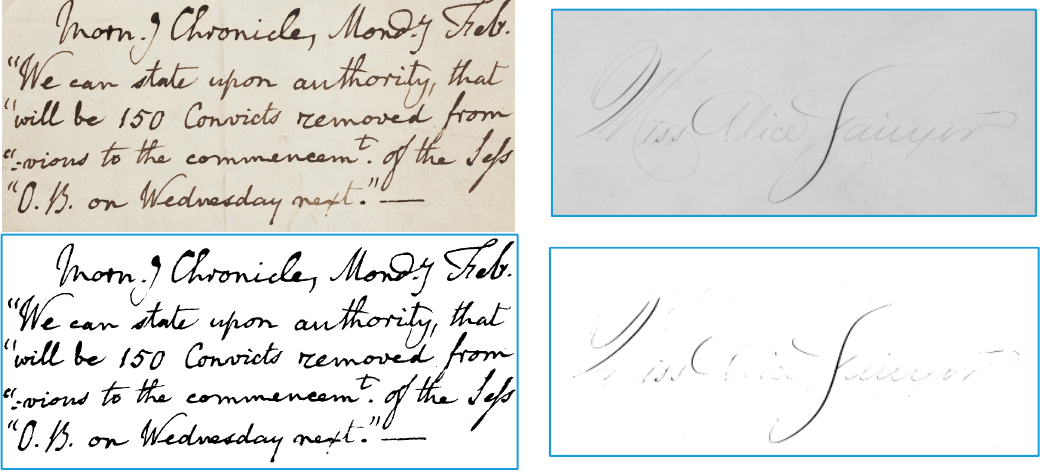
Figure 7. Two documents from DIBCO dataset: ( left-top ) original image ( left-bottom ) binary image obtained using the bilateral filter best result (P(f/f) = 97.05, P(b/b) = 99.88); ( right-top ) original image. ( right-bottom ) the worst binarization results for the bilateral filter (P(f/f) = 25.93, P(b/b) = 99.99).